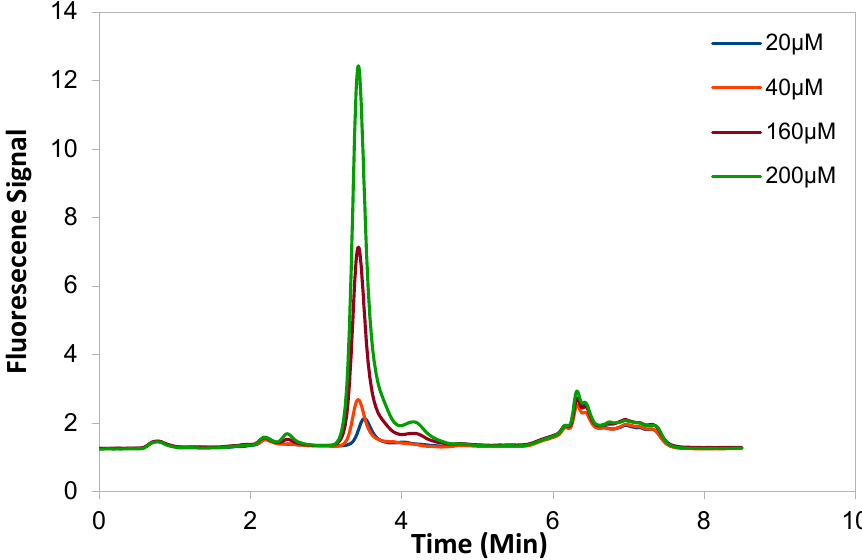
Figure 9. Overlaid chromatograms of the GSH standards at a wavelength of 450 nm.